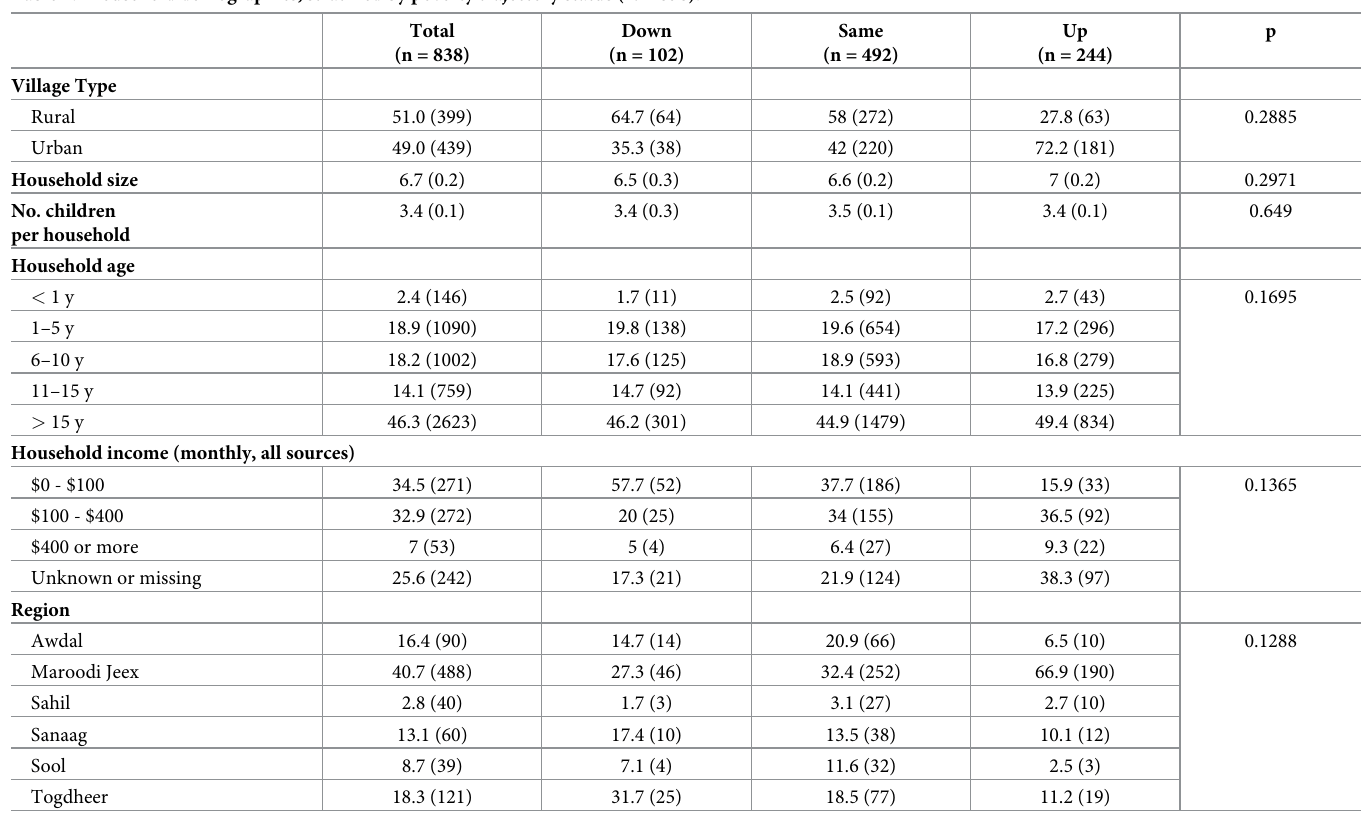
Table 2. Household demographics, stratified by poverty trajectory status (N =